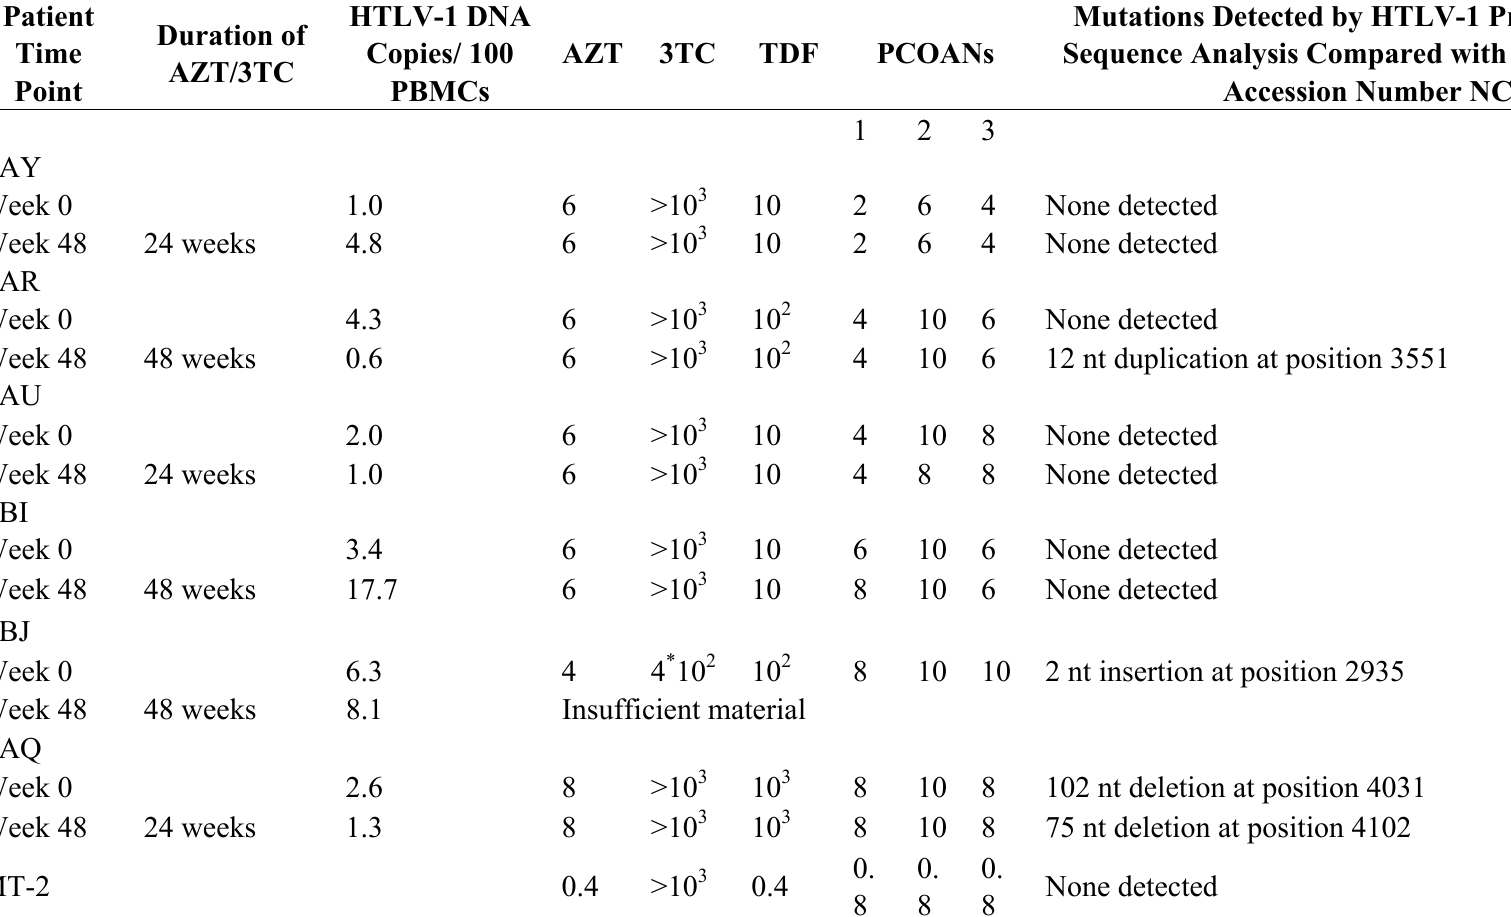
Table 2. In vitro human T-lymphotropic virus type 1 (HTLV-1) RT inhibitory concentrations